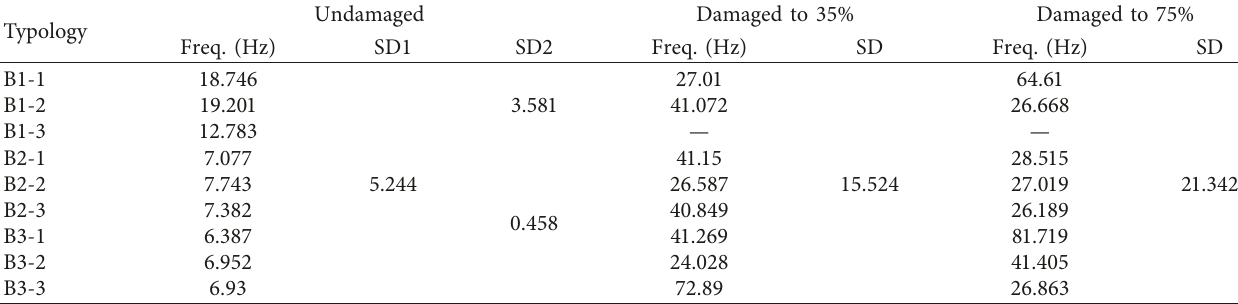
Table 6: Frequency values and standard deviation (SD) for the 1st torsional modal shape.